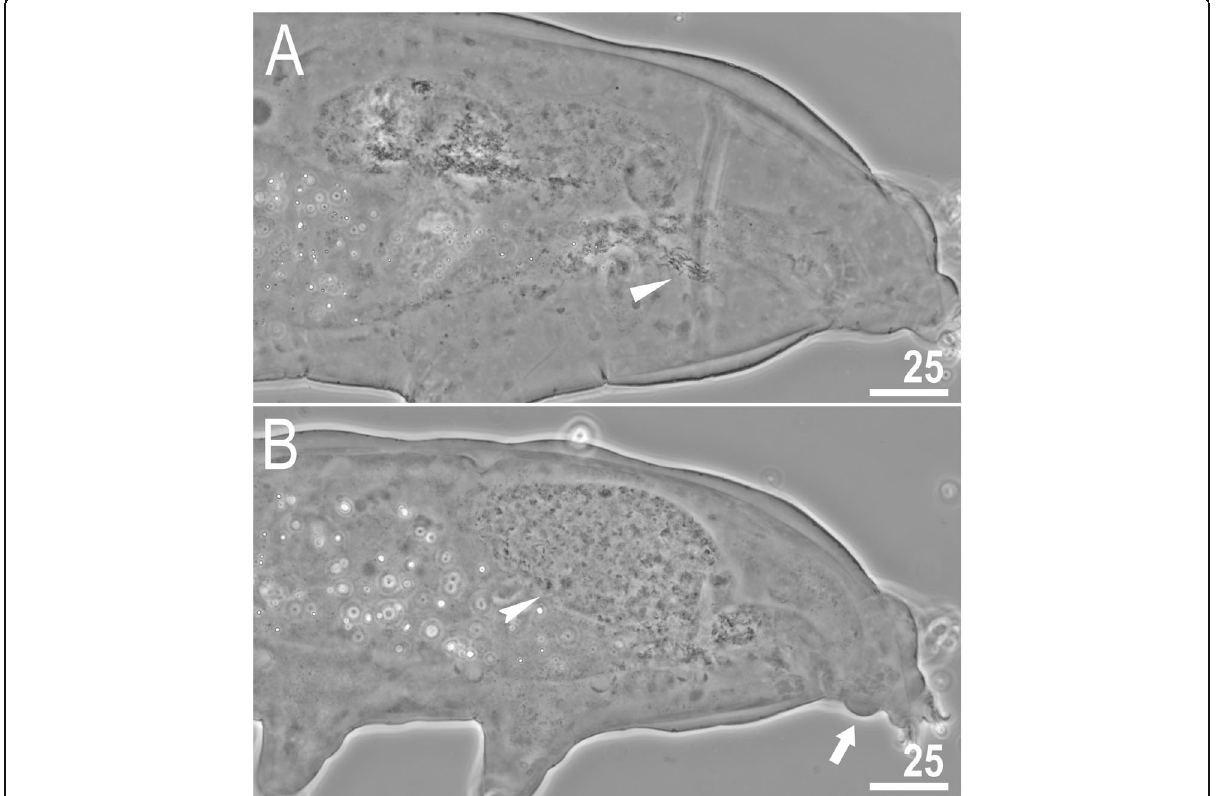
Fig. 38 Macrobiotus margoae sp. nov. from the USA (US.057) – reproduction (LCM): a – spermatheca (seminal vesicle) filled with spermatozoa and visible in females freshly mounted in Hoyer ’ s medium; b – testis filled with sperm visible in a male freshly mounted in Hoyer ’ s medium. The flat arrowhead indicates the female spermathecae, the indented arrowhead indicates the testis, and the arrow indicates gibbosity on the IV leg. Scale bars in μ